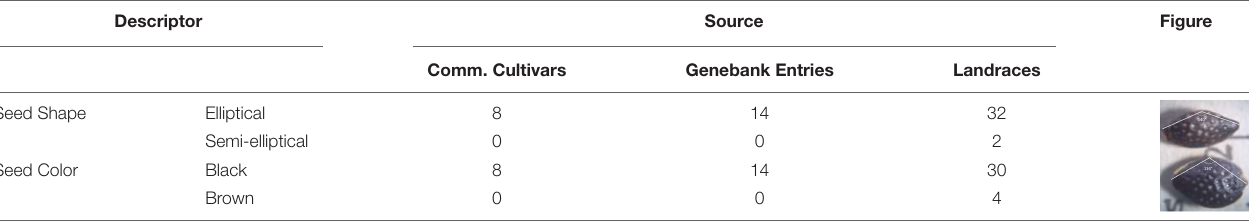
TABLE 3 | Qualitative traits measured on the seed of 56 genotypes of purple passion fruit ( Passiflora edulis f. edulis